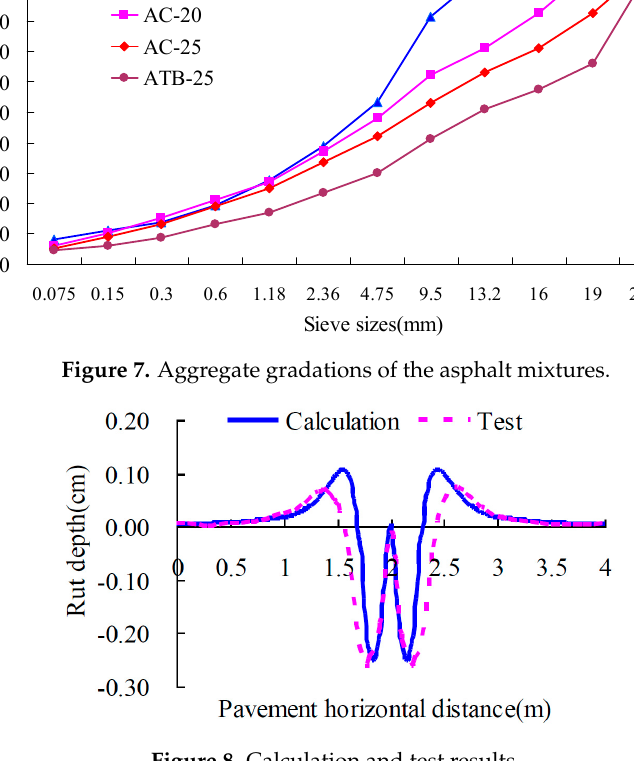
Figure 8. Calculation and test results. Figure 9. Calculation results of different pavement structure